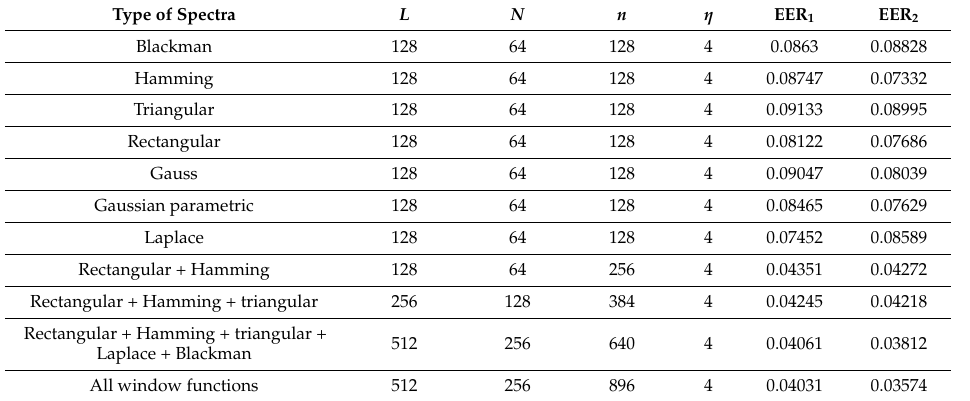
Table 4. Error probabilities of user personality verification with the image of one ear using features extracted by the encoder based on architectures 1 and 2 (with C + = 0.5, C - = 0.5, AUC MAX = 0.3, K G = 8).